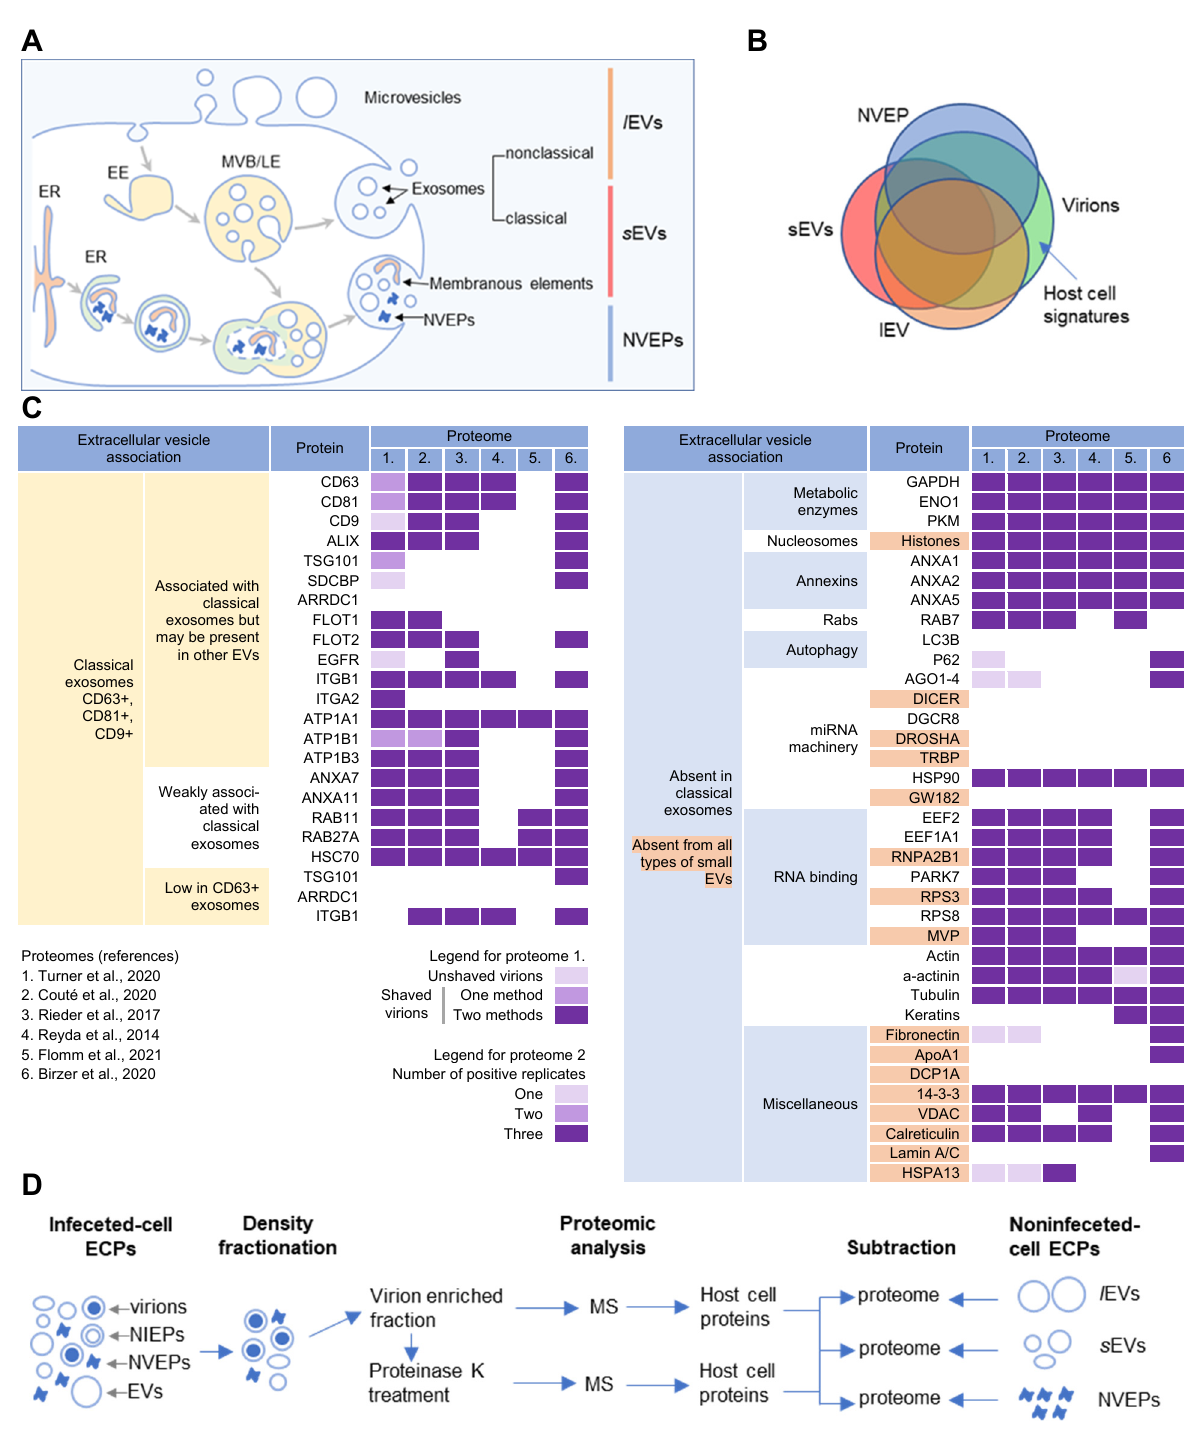
Figure 2 . Extracellular nanoparticle content within preparations of beta ‐ herpes virions. ( A ) Schematic representation of extracellular nanoparticle biogenesis via plasma membrane (PM), exosome, and amphisome ‐ dependent pathways. Microvesicles and non ‐ classical exosomes segregate as large (l) extracellular vesicles ( l EVs), whereas classical exosomes segregate as small (s) extracellular vesicles ( s EVs). Non ‐ vesicular extracellular particles (NVEPs) and vesicular elements are released by amphisome ‐ dependent and exosome ‐ independent secretion [16–18]. ( B ) Schematic representation of the expected proteomic overlap between lEVs, sEVs, NVEPs, and extracellular virion prepara ‐ tions. ( C ) Reassessed nanoparticle content [16] identified in HCMV and HSV ‐ 1 extracellular virion proteomes. Proteins were identified in five proteomes of HCMV virion preparations (proteome 1– 5) and one proteome of HSV ‐ 1 heavy particles (proteome 6). Proteome 1 [10] presents data for un ‐ treated HCMV virion preparations (unshaved) and the same preparation treated with proteinase K